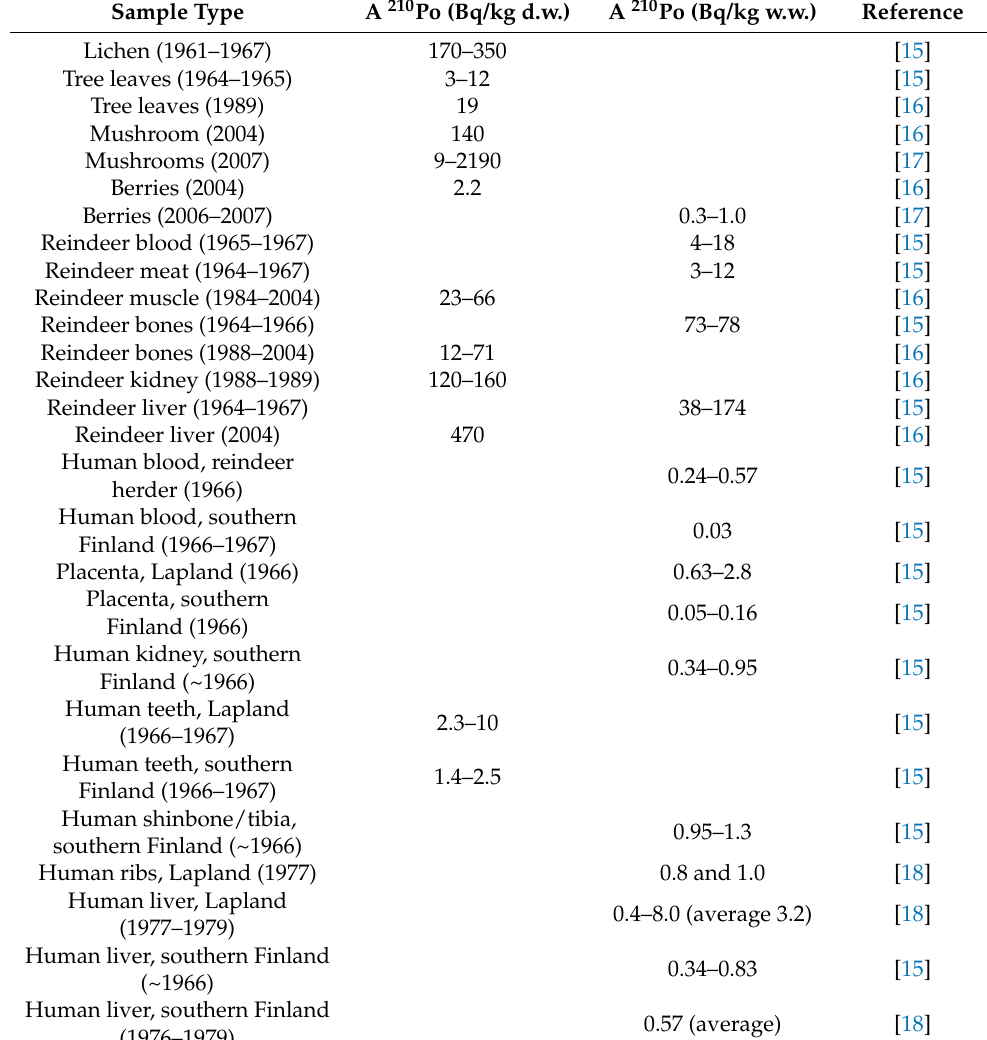
Table 2. Concentration of 210 Po in Finnish environmental and biological samples. Sampling year is in